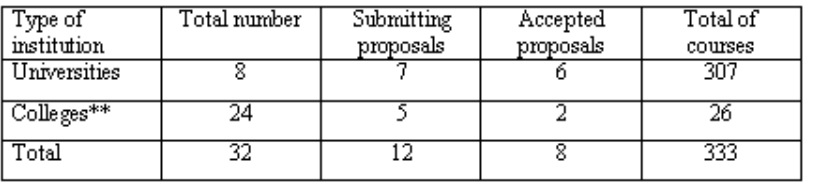
Table 1: Proposals for Implementing IT into the Israeli Higher Edu-